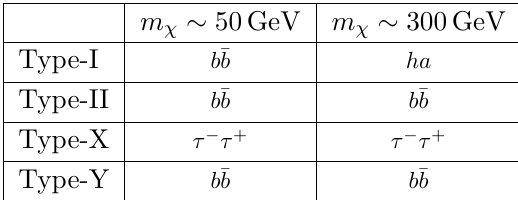
Table 6 . The dominant annihilation channels of each THDM-type near the funnel positions. The parameters are m a = 100 GeV, m A = 600 GeV, (cid:18) = 0 : 1, t (cid:12) = 40, c 1 = 0, c 2 = 1. m (cid:31) (cid:24) ( m h + m a ) = 2. For the larger m (cid:31) , the annihilation amplitude is suppressed by m (cid:0) 2 and g (cid:31) increases in proportion to m 2 . We (cid:12)nd that g (cid:31) > 1 for m (cid:31) (cid:21) 690 (cid:31)